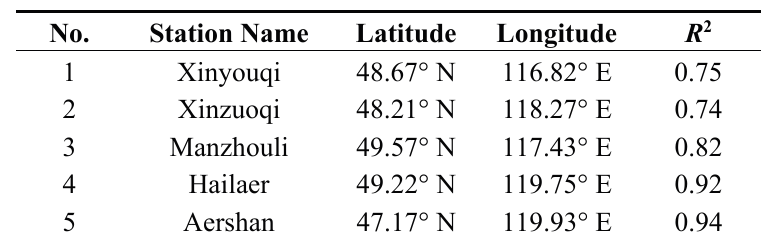
Table 1. Correlation between gauged precipitation with tropical rainfall measuring mission (TRMM) precipitation in respective grids.